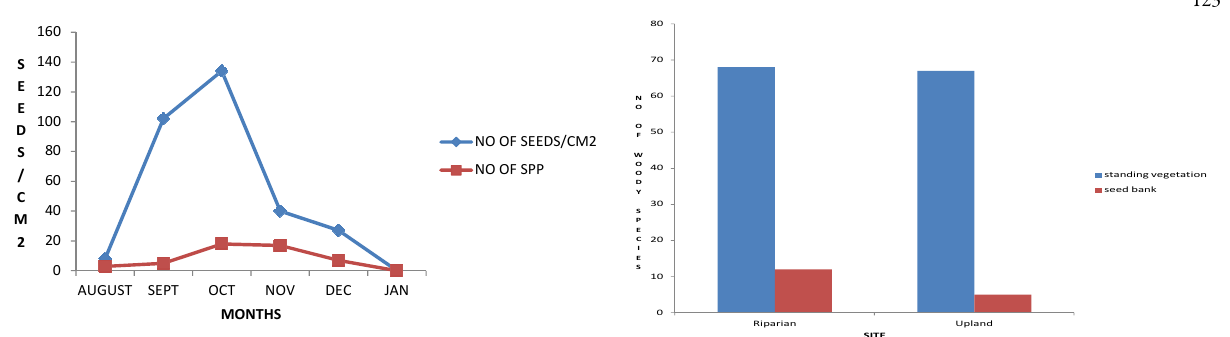
Fig. 7. Number of woody species in both standing vegetation and seed bank of the two vegetation